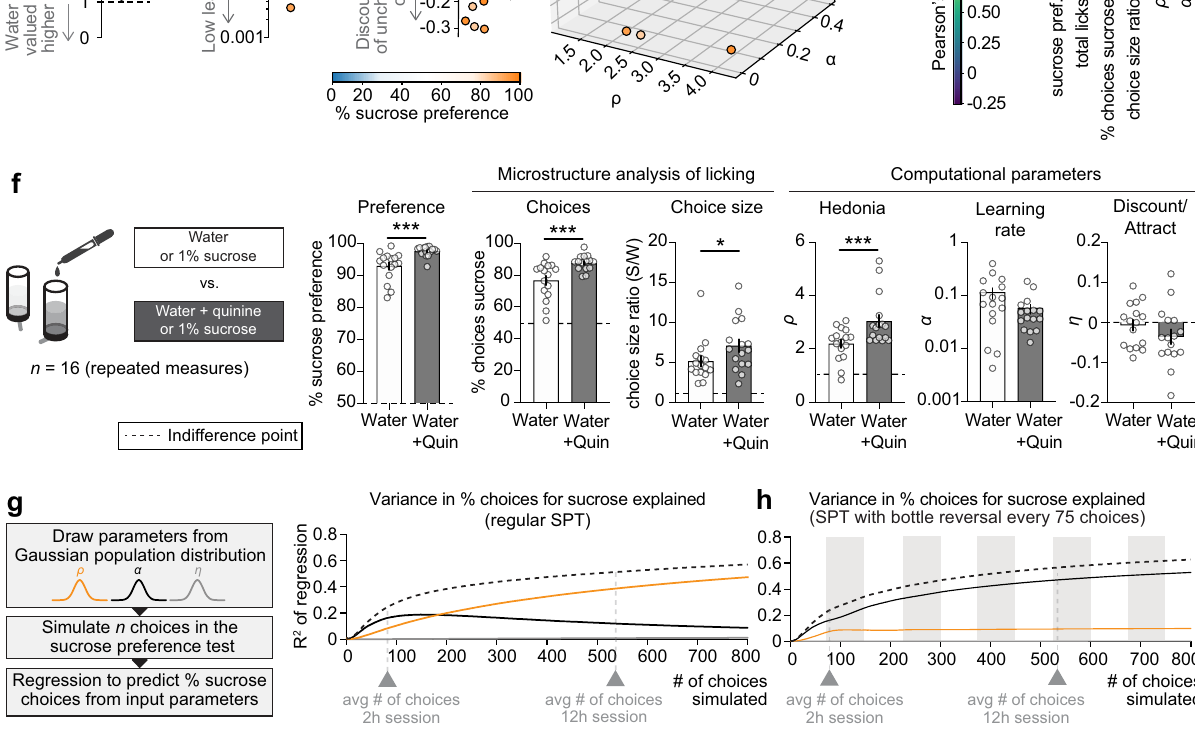
simulatedVariance in % choices for sucrose explained (SPT with bottle reversal every 75 choices)